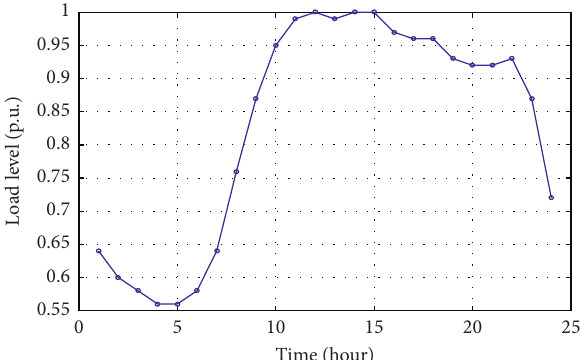
Figure 5: Variation of daily load